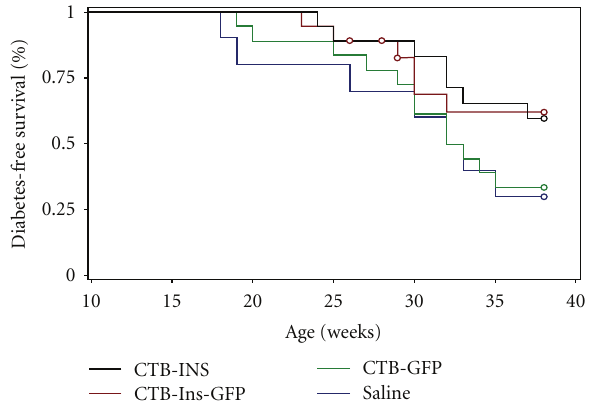
Figure 5: E ff ect of fusion protein feeding on diabetes development. Five-week-old female NOD mice were fed CTB-INS (group 1, n = 18, black), CTB-Ins-GFP (group 2, n = 18, red), CTB-GFP (group 3, n = 18, green), or Saline (group 4, n = 10, blue) four times per week until 38 weeks of age. Diabetes was confirmed by hyperglycemia ( > 16.7mM glucose) for 2 consecutive weeks. The ANOVA test revealed a significant reduction in T1D onset in groups 1 and 2 compared with groups 3 and 4 ( P = . 0276). No significant di ff erence was found between group 1 and group 2 ( P = .